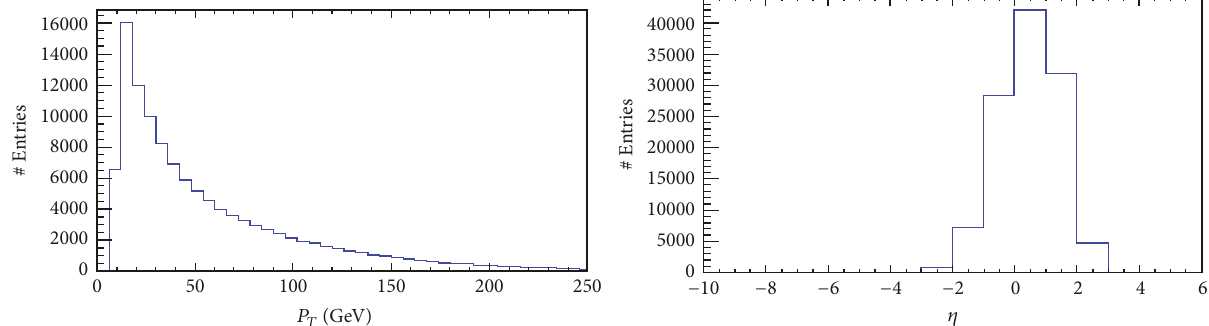
Figure 5: Transverse momentum and pseudo-rapidity distribution of electron from the process 𝑒 − 𝑝 → 𝑒 − 𝑊 ± 𝑞 + 𝑋 which includes both the background and signal for 𝜆 𝑢 = 𝜆 𝑐 = 0.05 at the